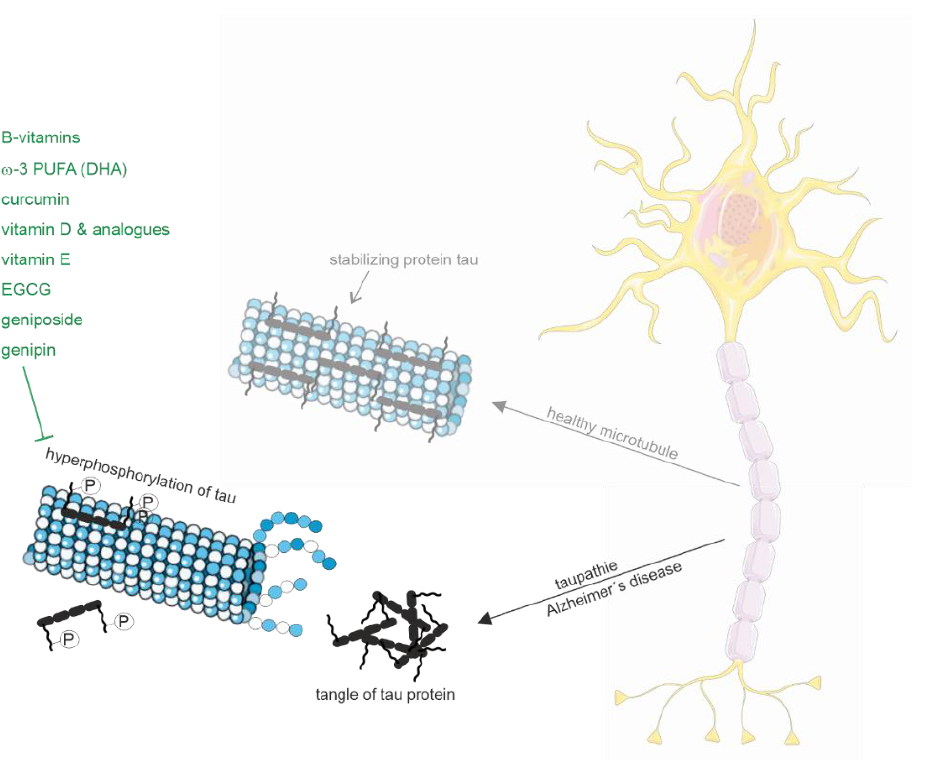
Figure 2. Influence of nutritional components on tau pathology. PUFA: polyunsaturated fatty acid. DHA: docosahexaenoic acid.